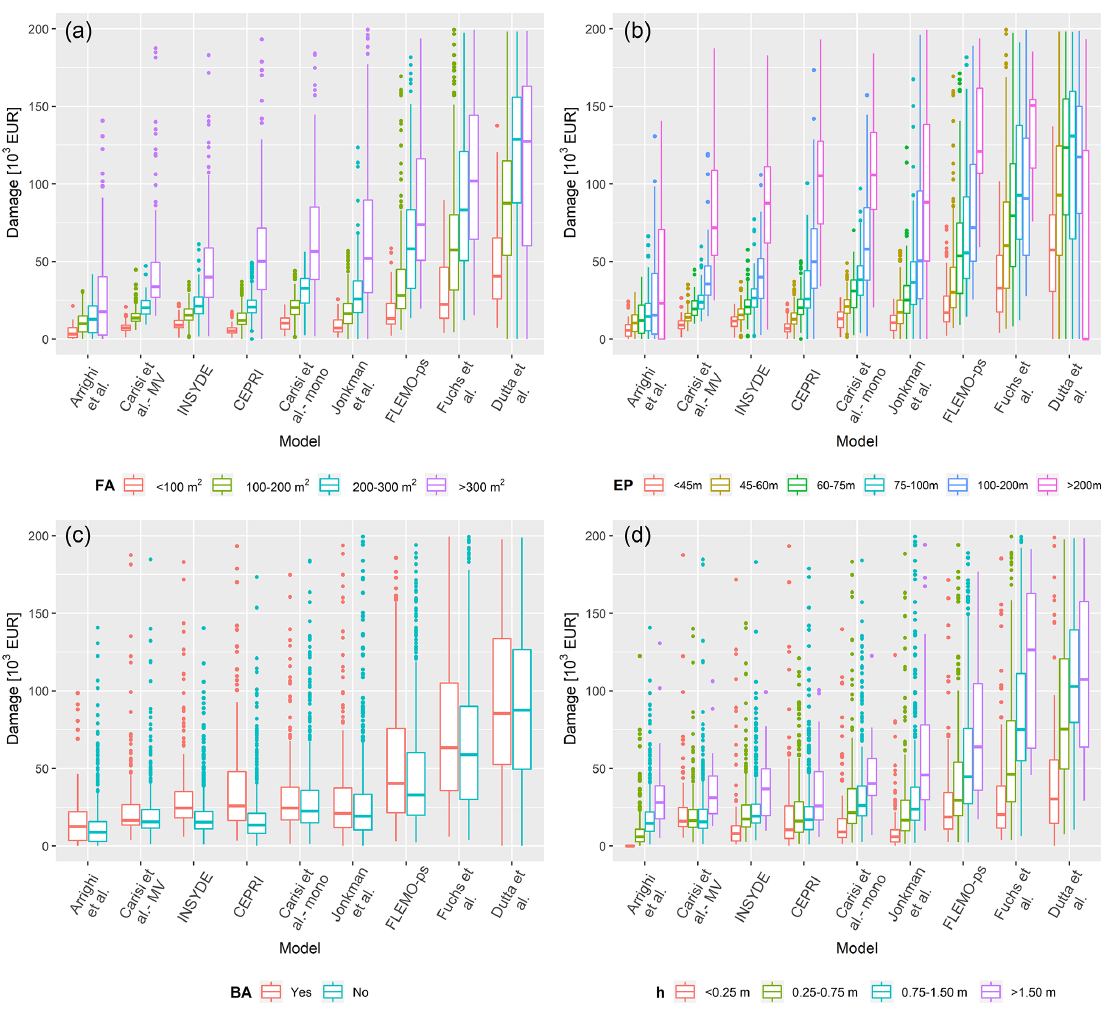
Figure 6. Box plots of damage estimates obtained with the tested models for different classes of footprint area – FA (a) , external perimeter – EP (b) , presence of basement – BA (c) , and water depth – h (d) . Models are organized according to increasing value of total damage